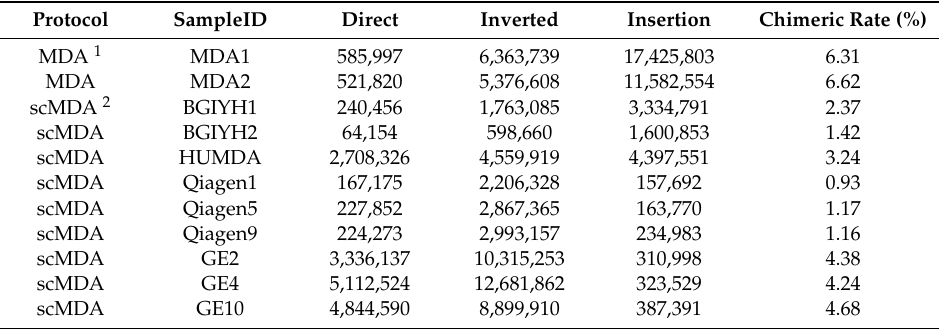
Table 2. The number of the chimeras detected from single cell sequencing data.